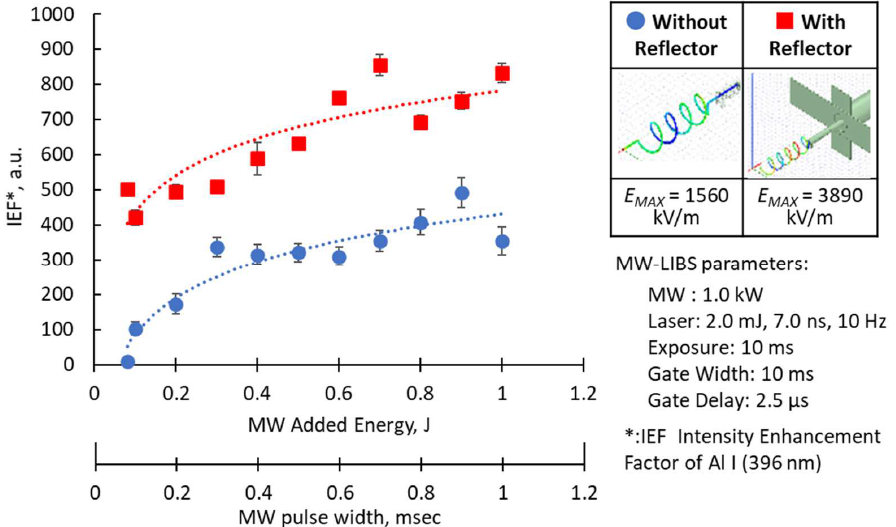
Figure 10. Experimental and simulated results with, and without, reflector